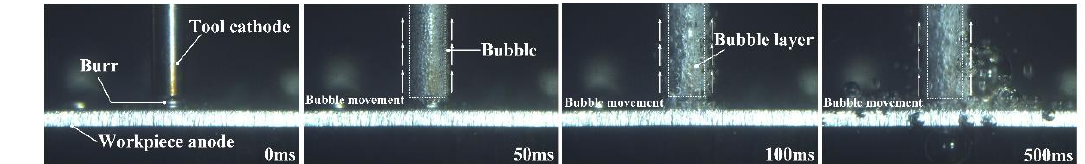
Figure 15. Machining process.